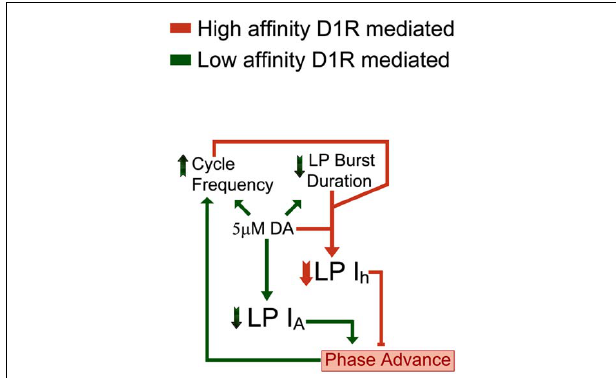
FIGURE 7 | DA (5 μ M) activates a closed loop. DA (5 μ M) acts at high affinity D1Rs to confer activity-dependence upon LP I h (DAD